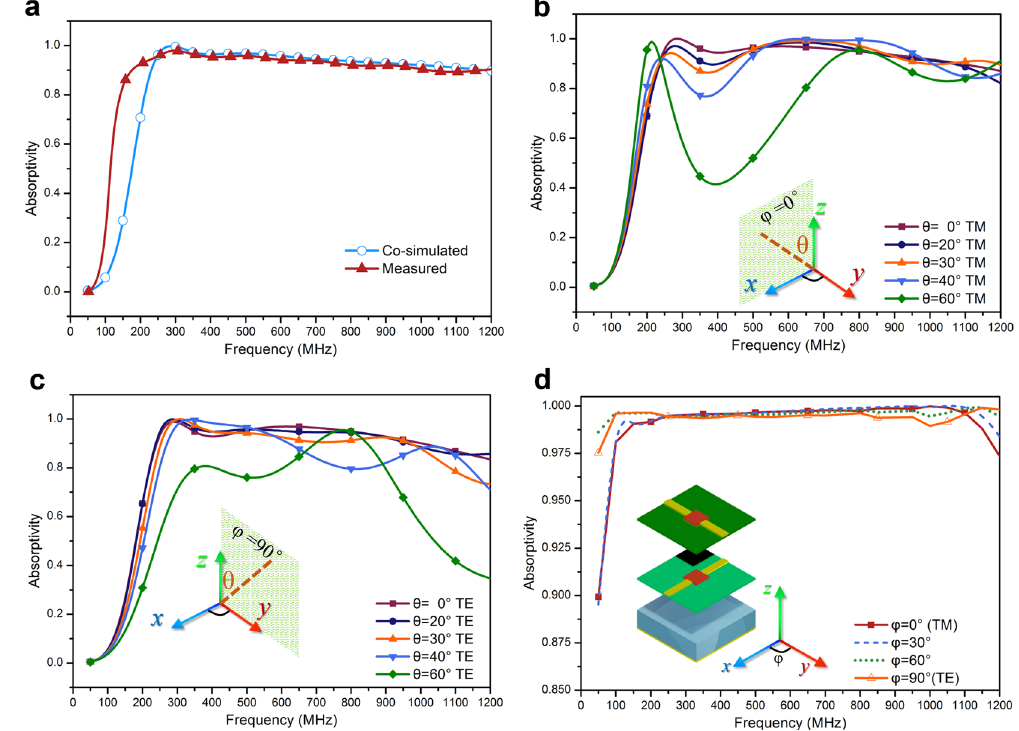
Figure 5. Performance of the NFMS magnetic absorber. ( a ) Measured absorptivity based on the parallel-plate waveguide based method, and simulated absorptivity based on the co-simulation method, where the layout shown in Fig. 4(b) is taken into simulation. ( b ) Simulated absorptivity under TM illumination with different oblique angles θ . ( c ) Simulated absorptivity under TE illumination with different oblique angles θ . Oblique incident results are obtained based on the same simulation approach mentioned above. ( d ) Conceptual configuration of the frequency-independent absorber’s unit cell, and its simulated absorptivity under normally incident wave with different polarization angles ϕ . The simulation is carried on the method used for Fig.